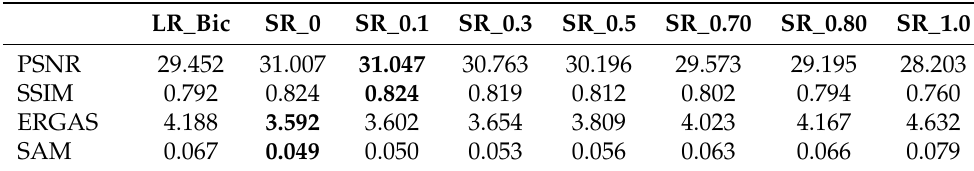
Table 2. RS-ESRGAN inference mean results on the test set of the Maspalomas dataset using different values of α . Best values in bold.